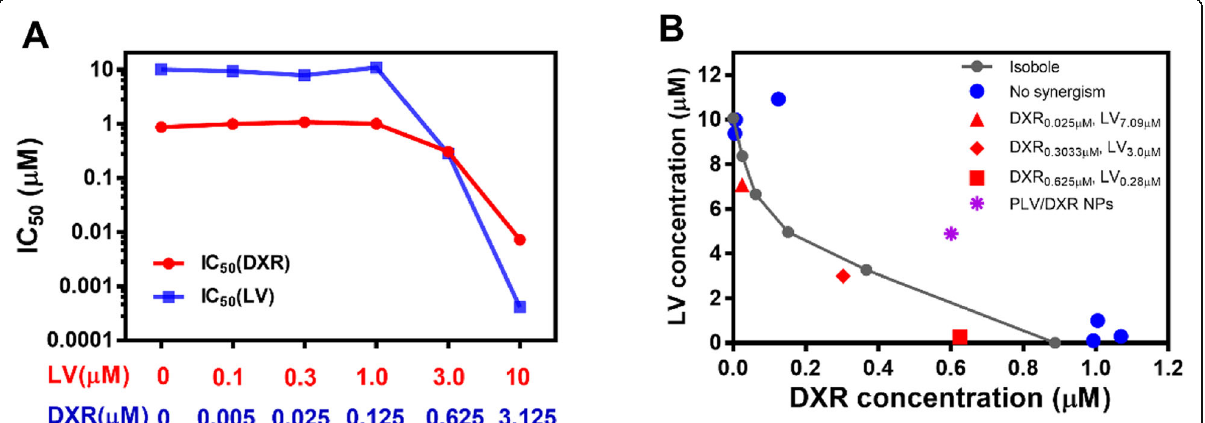
Fig. 2 Synergism of DXR and LV. IC 50 values for DXR and LV with different LV and DXR concentrations calculated by GraphPad Prism 7 ( a ) and the isobole method ( b